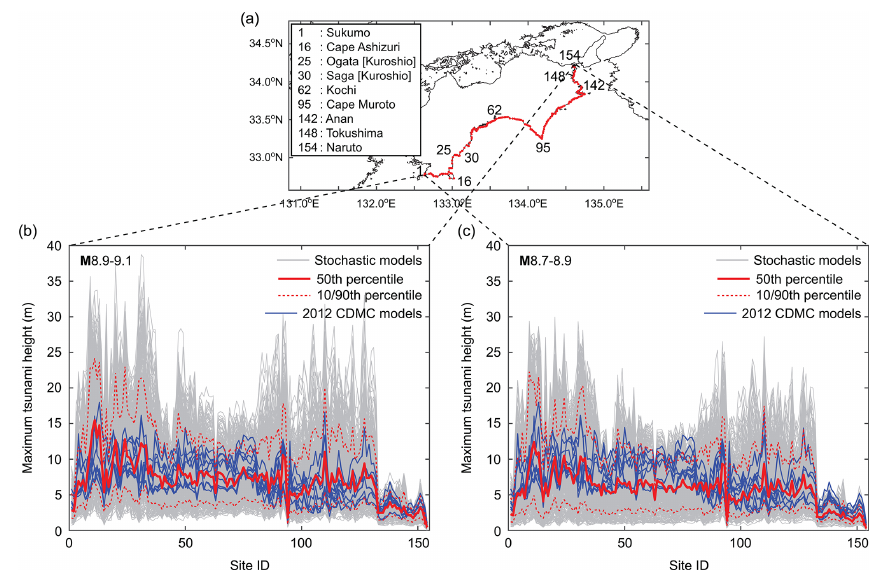
Figure 6. Maximum tsunami heights along the coast of Kochi and Tokushima prefectures (a) for the two magnitude ranges M 8.9–9.1 (b) and M 8.7–8.9 (c) . In (b) and (c) , maximum tsunami heights based on 500 stochastic models are shown with grey colours, the 50th percentile curve is shown with solid red lines, and the 10th and 90th percentile curves are shown with broken red lines. The blue curves correspond to the simulated maximum tsunami heights based on the 2012 CDMC models.